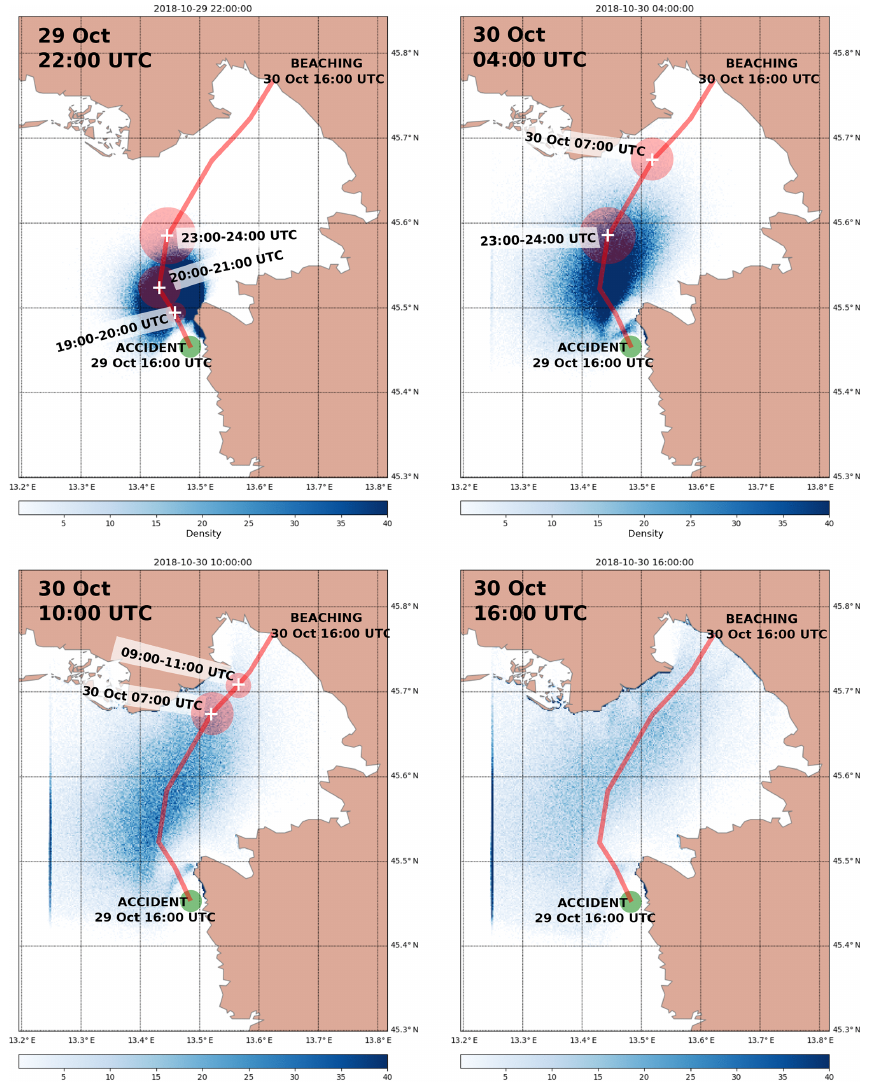
Figure 8. Lagrangian particle density (number of particles per cell area) from the OpenDrift simulation of the person-in-water object type. Lagrangian simulation drift is depicted every 6h (indicated by a timestamp in the upper left corner of each panel) after the accident on 29 October 2018 16:00UTC. The red line denotes drift trajectory as reconstructed by the survivor. White crosses and time inserts denote locations and times from the survivor’s trajectory estimate, while red circles around crosses denote the survivor’s uncertainty estimates of the respective